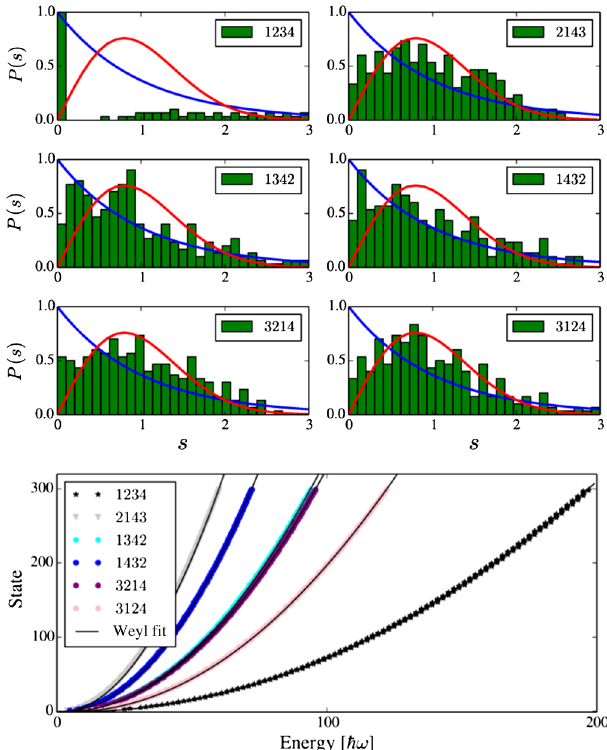
FIG. 4. Unfolded spectrum statistics for H 3 Coxeter masses with mass fractions μ 1 ¼ μ 4 ¼ 0 . 442 79 , μ 2 ¼ 0 . 033 81 , and μ 3 ¼ 0 . 080 61 . There are only six different sectors because of two equal masses m 1 ¼ m 4 and because Ω is congruent to Ω p 1 p 2 p 3 p 4 p 4 p 3 p 2 p 1 byinversion.Thevariable s isthenormalizedunfoldedenergylevel difference [20]. The integrable sector Ω 1234 is depicted in the top left graph and agrees with the prediction from Eq. (6c). The blue lines depict the Poissonian statistics expected for an integrable system; the red lines are Wigner-Dyson distribution derived from random matrix theory expected for quantum ergodic systems with time-reversal symmetric Hamiltonians. The bottom graph shows the quality of Weyl ’ s law Eq. (7) in the integrable sector Ω 1234 as well as the nonintegrable